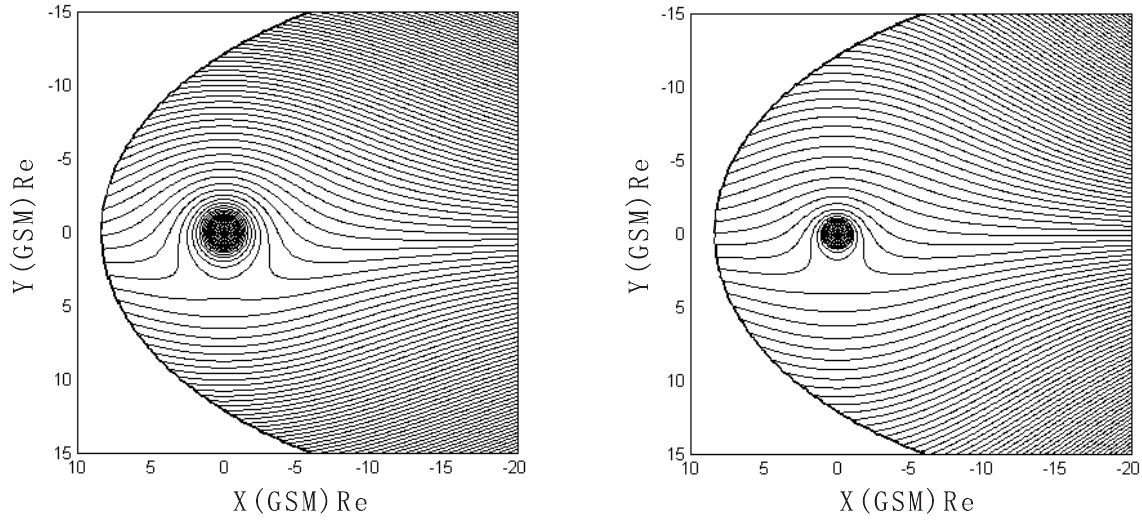
Fig. 4. Equipotential contours of the total electric field. Left: Sum of uniform convection electric field and corotation electric field. Right: Sum of convection, shielding and coratation electric